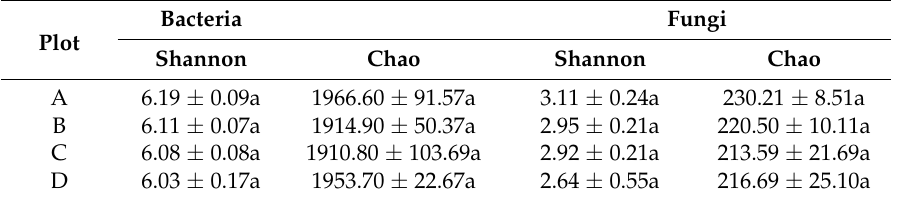
Table 3. Diversity indices for soil microbial community among different forest management methods.